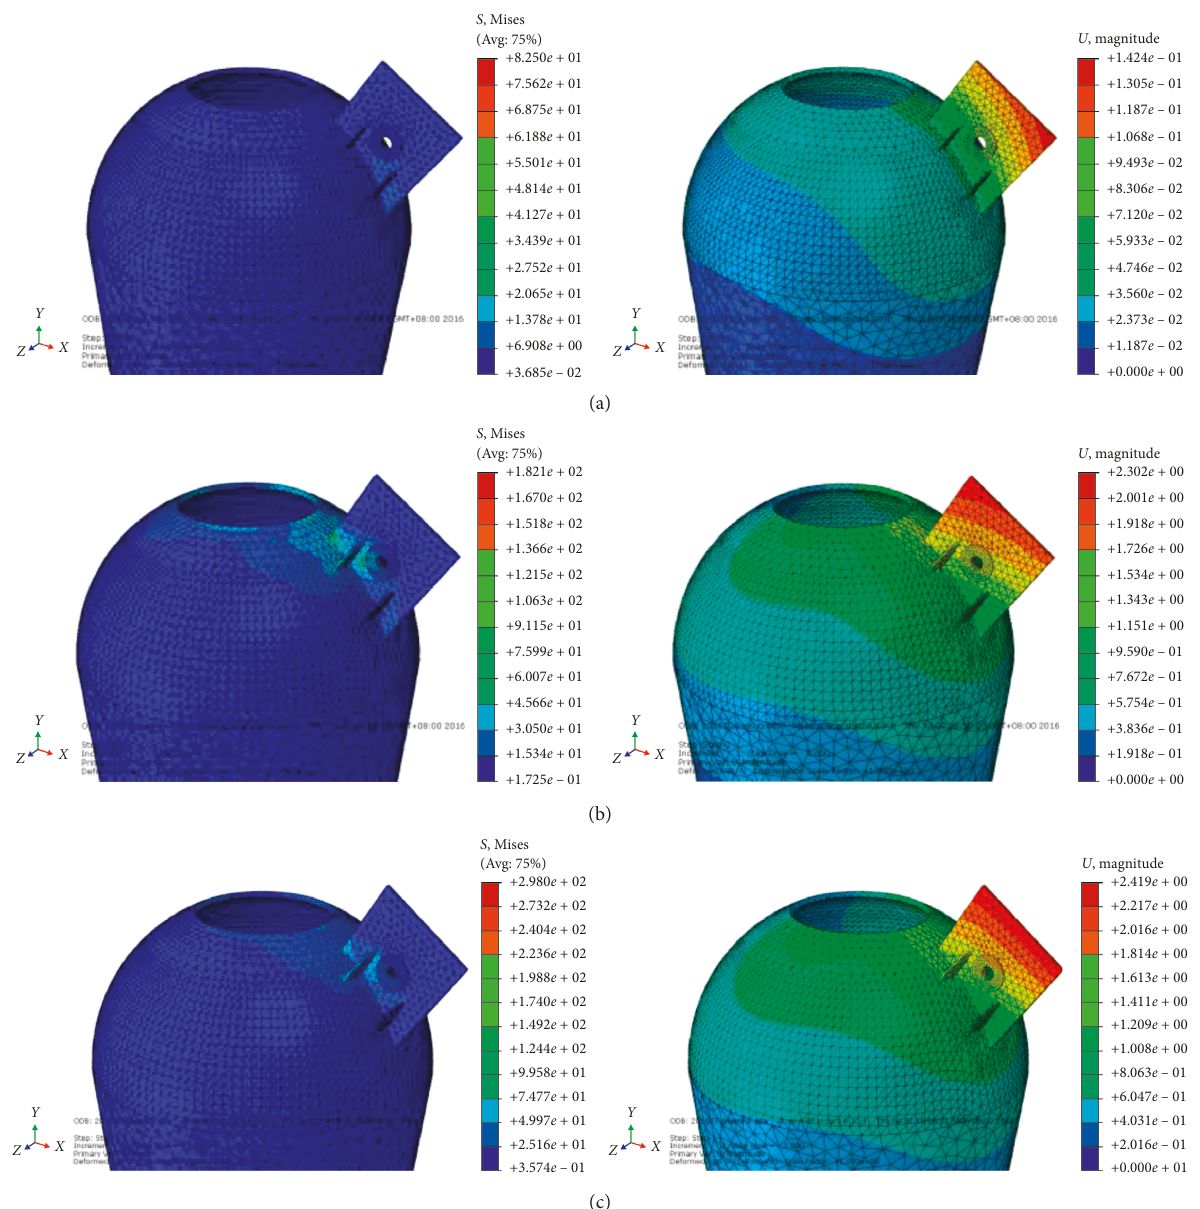
Figure 11: Stress and deformation nephograms under three different construction stages. (a) Stress and deformation nephograms in the hoisting emplacement stage. (b) Stress and deformation nephograms in lower cable fixation stage. (c) Stress and deformation nephograms in out-of-plane disturbance